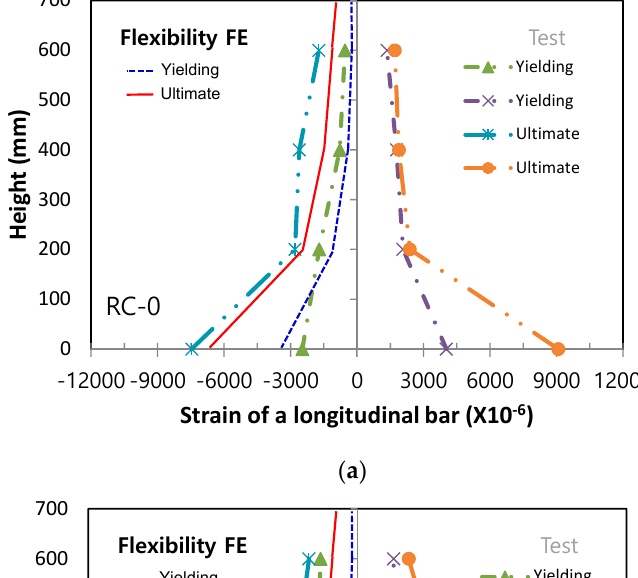
Figure 11. Experiments and stiffness finite element predictions for axial strains of steel bars, ( a )RC- 0, ( b ) RSH-s, ( c ) RSH-n.